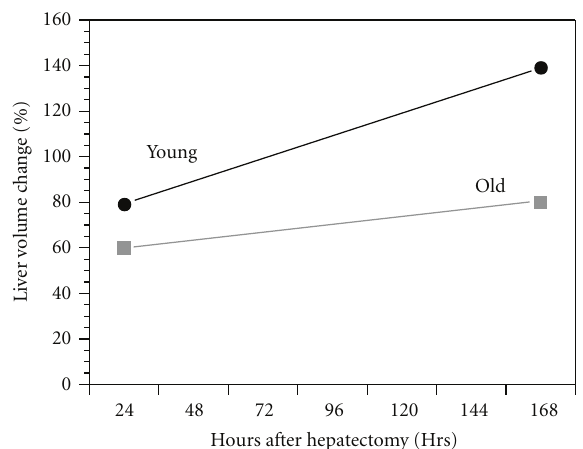
Figure 1: E ff ect of animal age on liver volume at two intervals following partial hepatectomy in young and old rats. Data derived from [15].